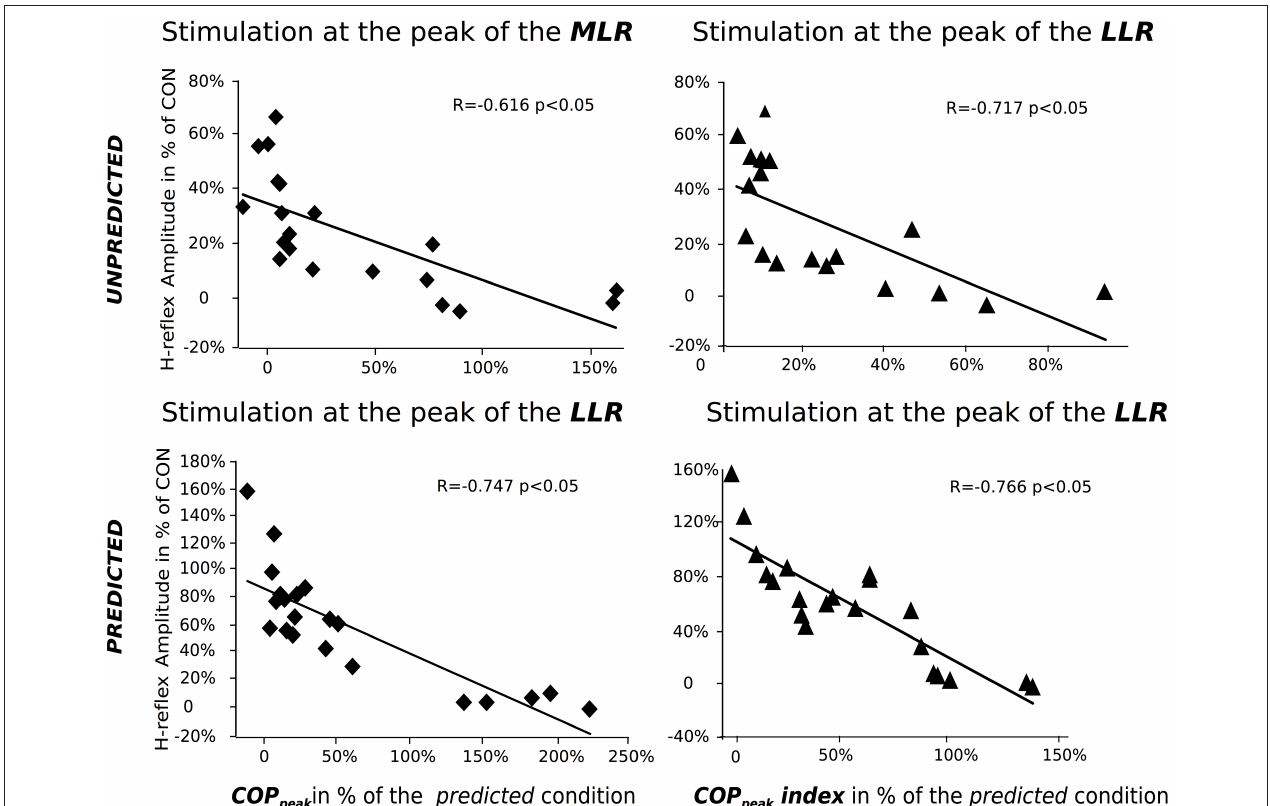
FIGURE 5 | Bivariate correlations among the variables center of pressure (COP), displacement (abscissa), and H-reflex amplitude (ordinate) for the unpredicted (top) and predicted (bottom) perturbation conditions. Graphs illustrate the interrelationship of COP peak (left) and COP peak index (right) with the Soleus H-reflex amplitudes elicited at the peak of the MLR (top left) and LLR (top right and bottom), respectively. Correlation coefficients and regression lines indicate a negative relationship between the neuromuscular and kinematic variables, with almost linear muscle- and phase-specific